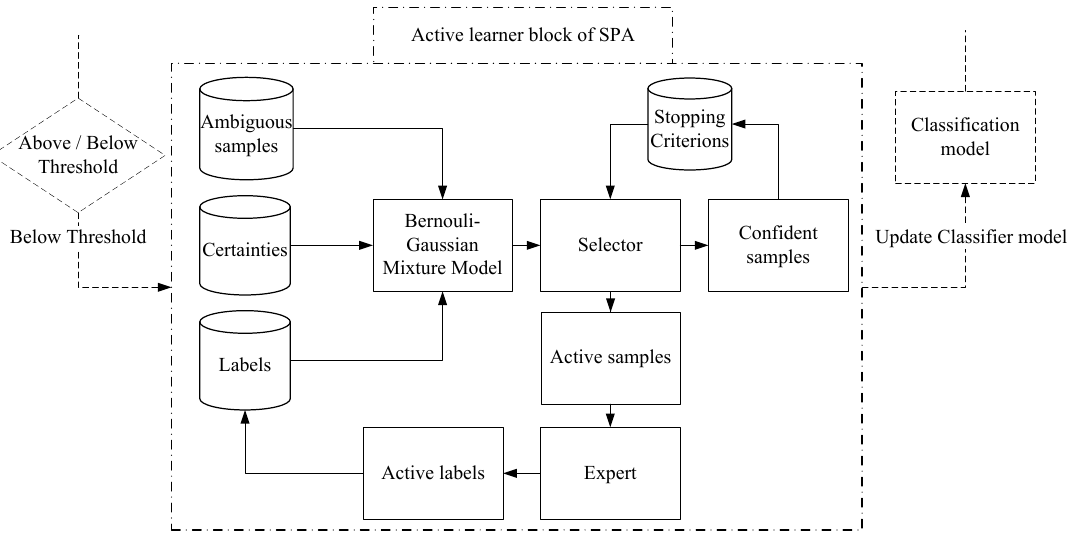
Figure 4. Schematic flow of active learner block based on Bernoulli-Gaussian model. This model takes the ambiguous samples along with the base classifier’s label prediction with its certainty as